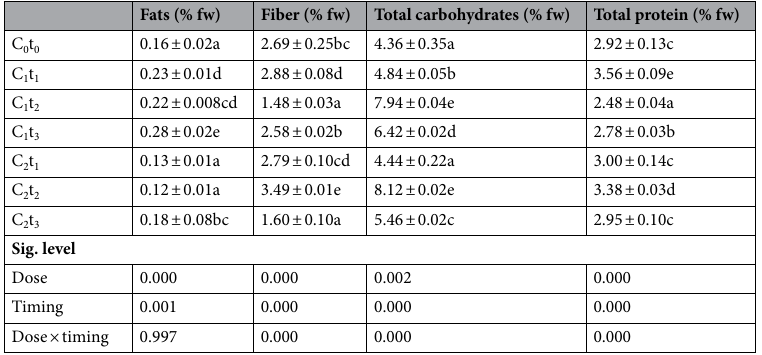
Table 2. Composition of P. ostreatus mushrooms cultivated on supplemented substrates. C 1 3 g kg −1 , C 2 5 g kg −1 , t 1 supplementation at spawning, t 2 supplementation after the first harvest, t 3 supplementation at spawning and after the first harvest. Values are means; means within the same column followed by the same letters are not significantly different at P < 0.05 according to Duncan’s multiple range